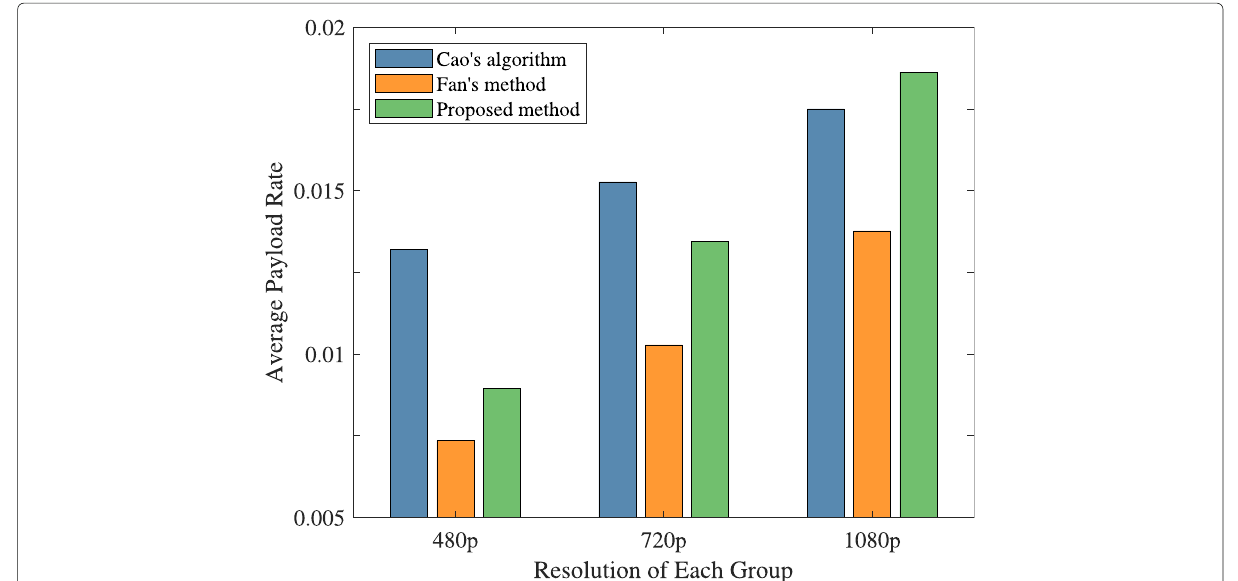
Fig. 13 The average payload rate P e of three group of videos with resolutions of 480p, 720p, and